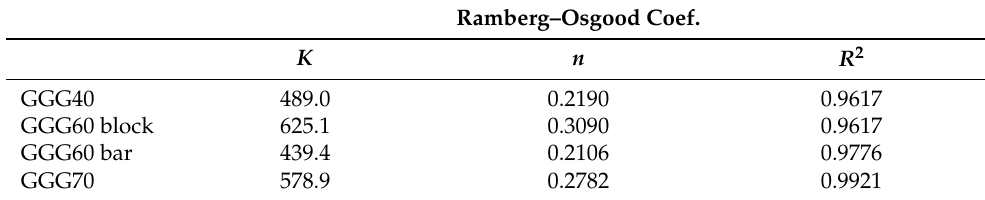
Table 2. Ramberg–Osgood curve-fitting results for GGG40, 60 and 70. Ramberg–Osgood Coef.